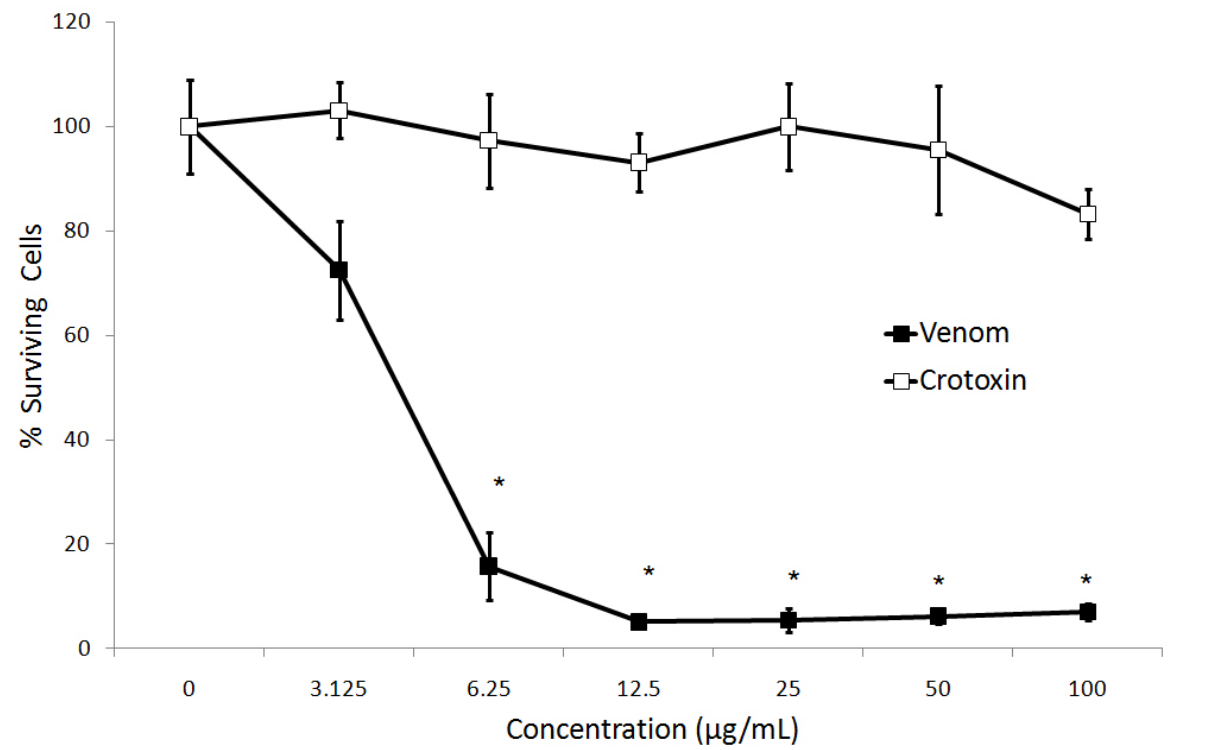
Figure 5. Cytotoxic effect of C. d. cumanensis venom (black squares) and crotoxin (white squares) – both applied in the concentration range of 3.12-100 µg/mL – on MDCK cells by the MTT method. Data are expressed as means ± SEM, ANOVA, Dunnett’s post-test,* p < 0.05, compared to the corresponding control